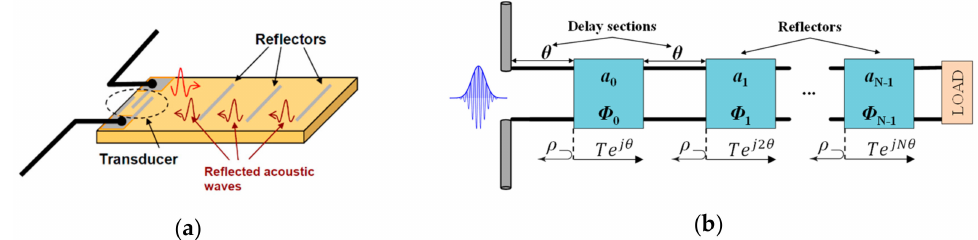
Figure 1. Working principle of a chipless radiofrequency identification (RFID) system based on ( a ) surface acoustic wave (SAW) technology and ( b ) delay lines. In both cases, the functionality is known as time domain reflectometry